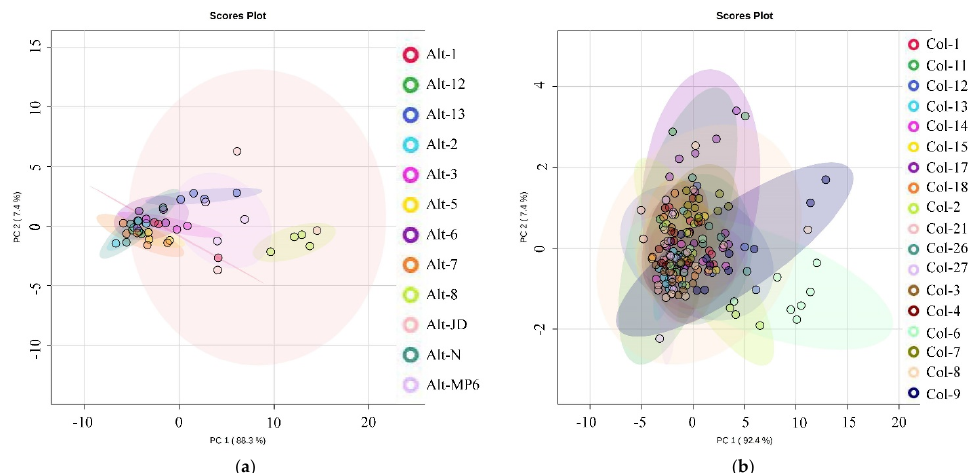
Figure 6. Principal component analysis (PCA) of conidial features of isolates of Alternaria ( a ) and Colletotrichum ( b ).